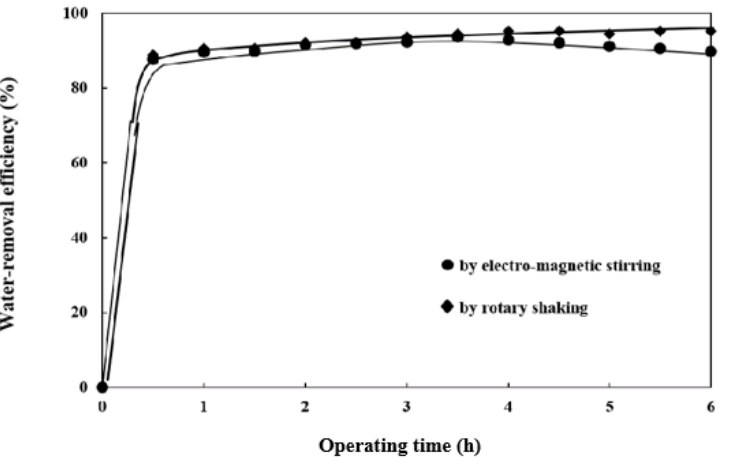
Figure 4. Effects of vibrating motion on water-removal efficiency of molecular sieves from ethanol.